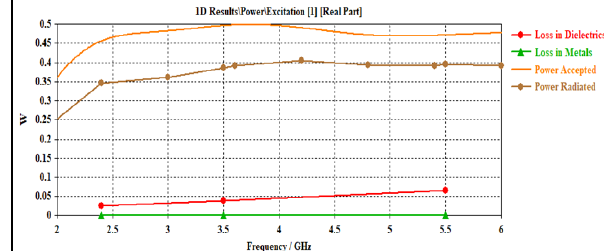
Figure 6. Power loss curve v/s frequency.